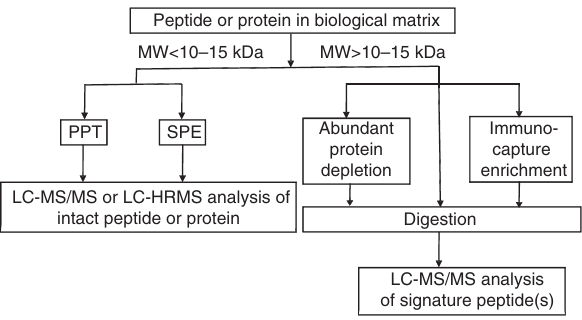
Figure 1 General workflow for LC-MS-based peptide and protein